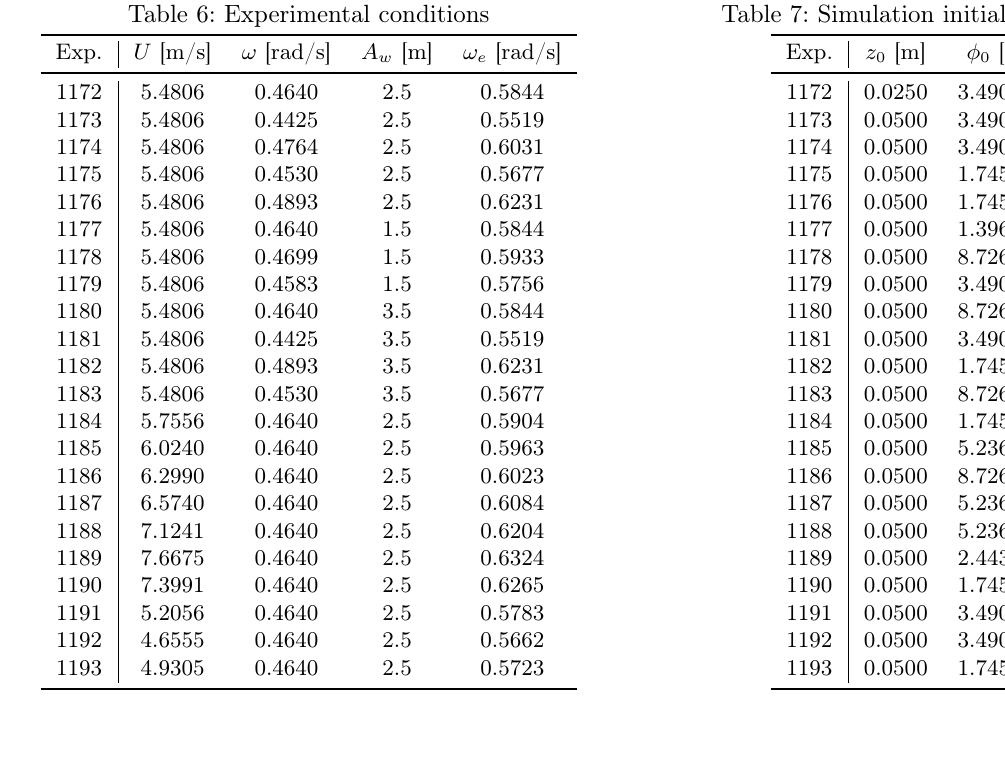
Table 8: Simulation